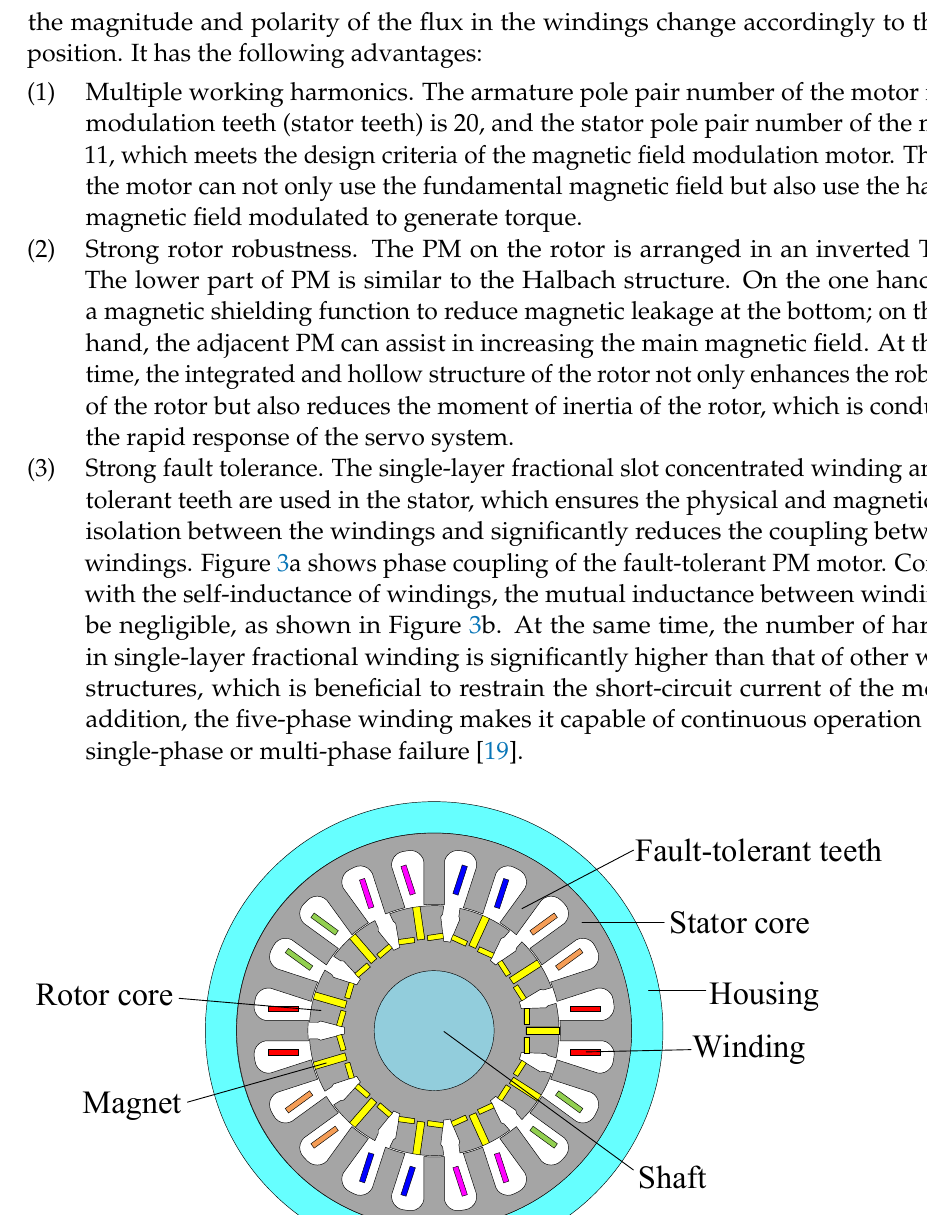
Figure 2. Flux analysis of the FTPM motor. ( a ) A1 is positive. ( b ) A1 is negative.